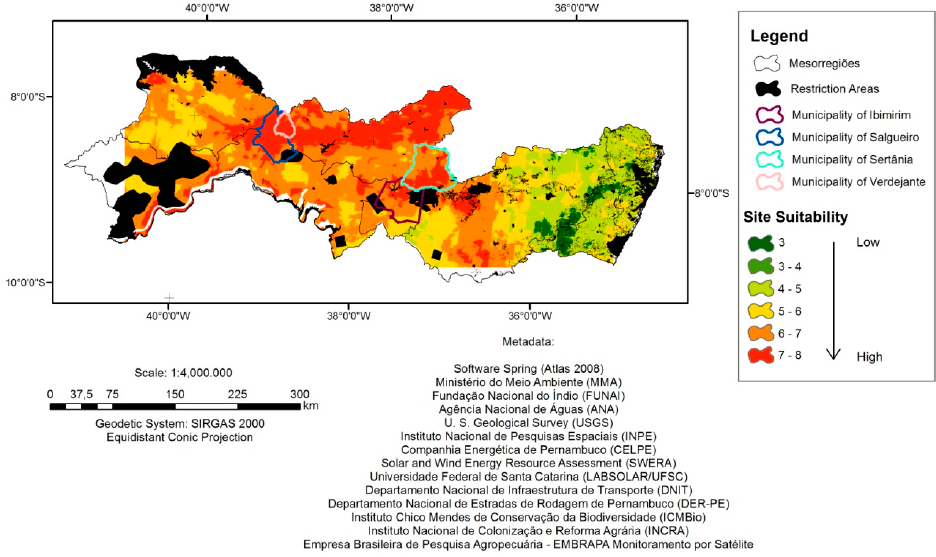
Figure 13. Site Suitability Map for the Installation—Scenario 2.